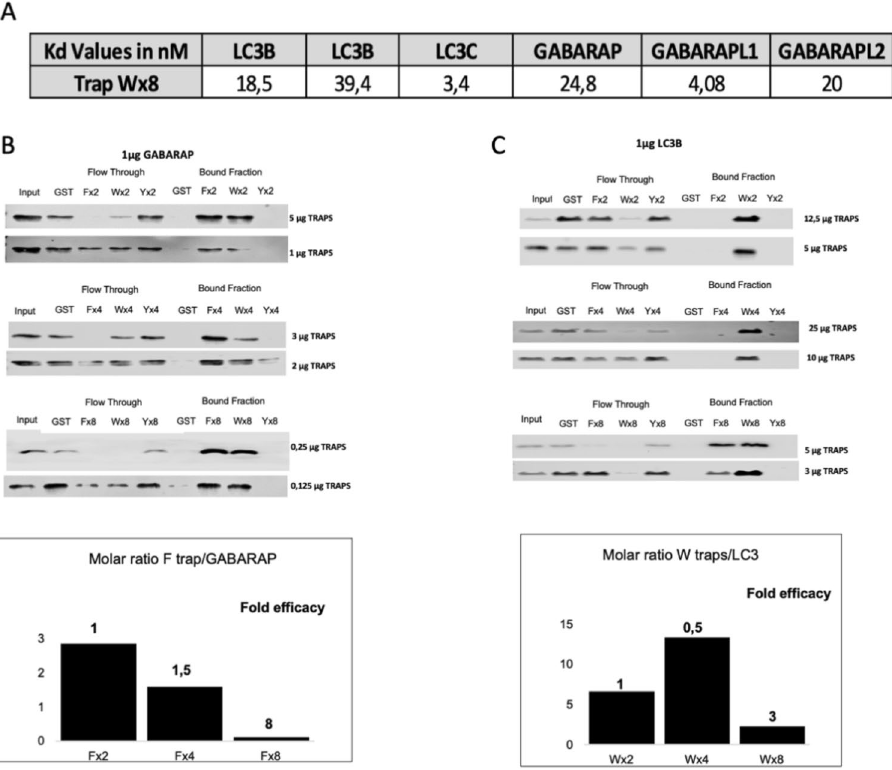
Figure 2. In vitro validation and characterization of LC3 traps. ( A ) Affinities between Wx8 traps with GABARAP or LC3 proteins were measured using microscale thermophoresis (MST). Kd values included in the table. Experiments were performed in duplicate. In vitro binding of GABARAP ( B ) or LC3B ( C ) with LC3-traps with 2, 4 or 8 LIRs using recombinant purified proteins. GST pulldown assays were used to analyze the capacity of distinct LC3-traps to capture recombinant LC3/GABARAP proteins. Various concentrations of LC3-traps were used to capture 1 mg of GABARAP or LC3B proteins. The graphs show the molar ratio used between trap and target as well as the fold efficacy between observed for traps with 2, 4 and 8 LIRs. Experiments performed twice. Input, Flow Through and Bound Fractions were analyzed by Western blot with specific antibodies against GABARAP or LC3B. Images of PVDF membranes were cut after antibody hybridization to optimize